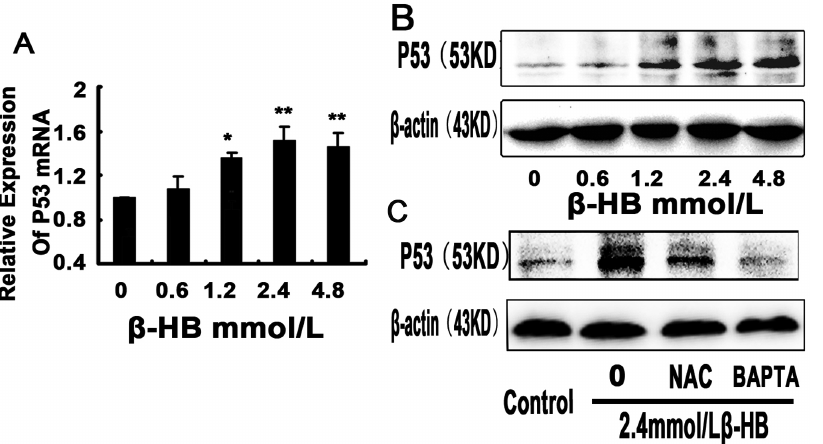
Figure 4. Effect of b -HB on the expression of p53 in BSMCs. Cells were incubated 48 h with b -HB (0, 0.6, 1.2, 2.4 or 4.8 mM) in serum-free medium. A) p53 mRNA was detected by Q-PCR, and the ratio of p53 to b -actin was calculated. B) p53 protein was detected by Western blot, and the ratio of p53 to b -actin was calculated. C) Cells were incubated 48 h with b -HB (0, 2.4 mM) in serum-free medium with or without pretreatment with NAC (1 mM) or BAPTA/AM (15 m M). The mean of three independent experiments is shown. *p , 0.05, **p , 0.01 versus control group.